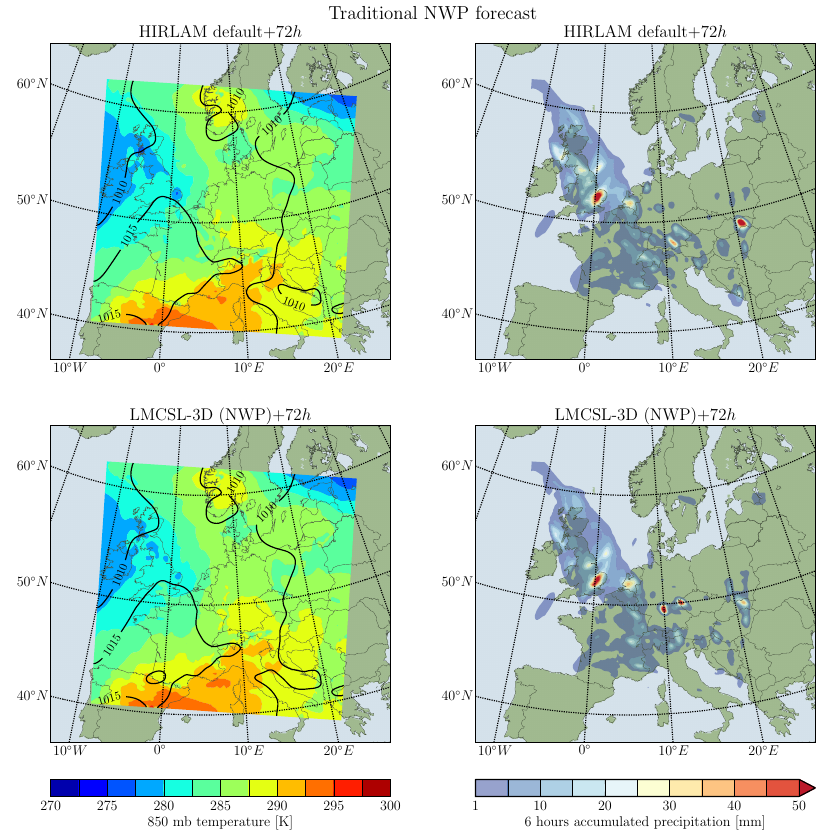
Fig. 4. Comparison between HIRLAM and LMCSL-3D in a 72h NWP forecast. Upper row shows the traditional HIRLAM forecast, and in the lower row the corresponding LMCSL-3D forecast is shown. The left column shows the mean sea level pressure as contour lines on top of an 850mb temperature contour field. The right column shows 6h accumulated total precipitation.